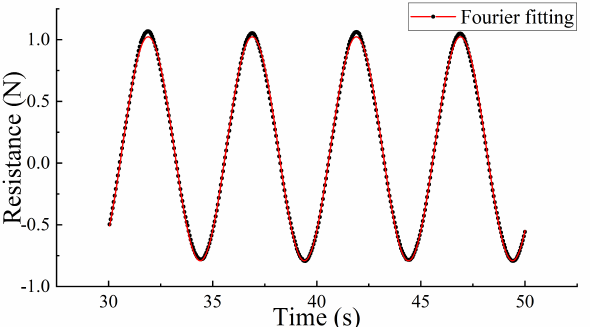
Figure 14. Change of heaving force of underwater vehicle at f = 0.6 Hz and its Fourier fitting.